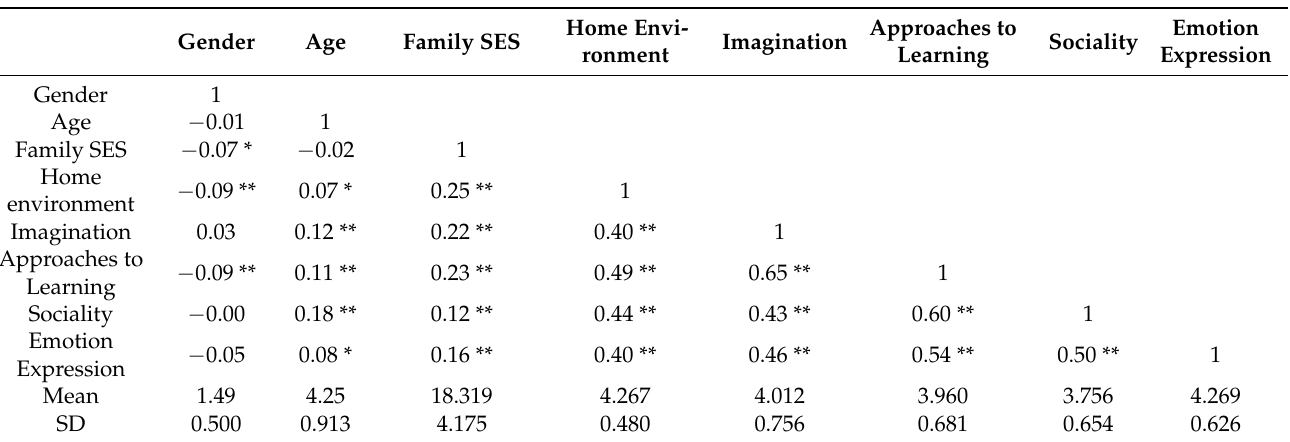
Table 2. Descriptive Statistics and Correlations of Study Variables 1